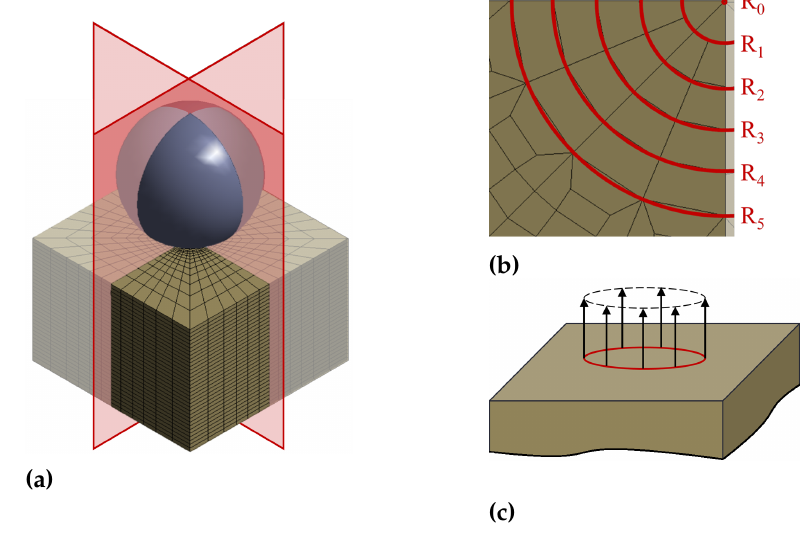
Figure 3. Considerations for the FEM model of the piezoelectric kick-actuator: ( a ) Symmetry allows to simulate only one quarter of the model, saving computational effort. ( b ) A mapped mesh of concentric circles around the location of contact results in equal vertical nodal forces per ring. The center node and the five rings are enumerated from R 0 to R 5 . ( c ) Contact-induced forces on the kick-actuator are equal per ring. Black arrows indicate the vertical force distribution for a single ring. Separately modelling the sphere and the kick-actuator provides access to the MOR methodology proposed in